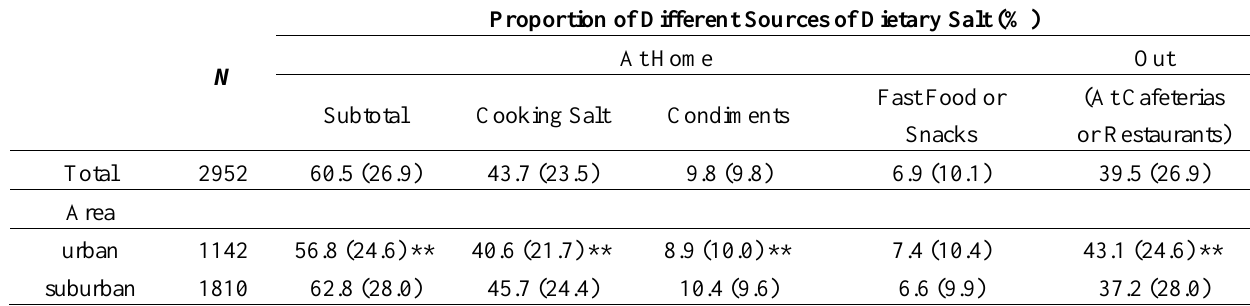
Table 2. Sources of dietary salt intake (mean (standard